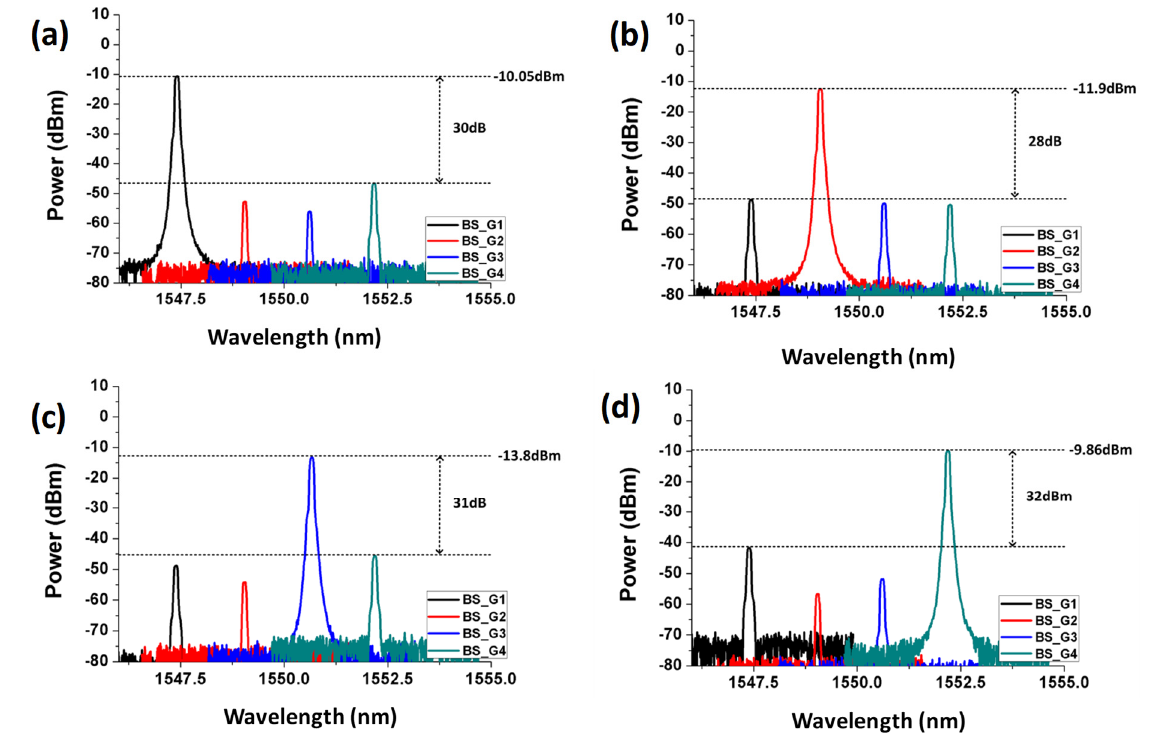
Figure 10. Spectrum measured at the receiving end of BS when the downlink optical signal is captured by SBOADM to the BS in ( a ) BS-Group1, ( b ) BS-Group2, ( c ) BS-Group3 and ( d ) BS-Group4 when a breakpoint occurs.